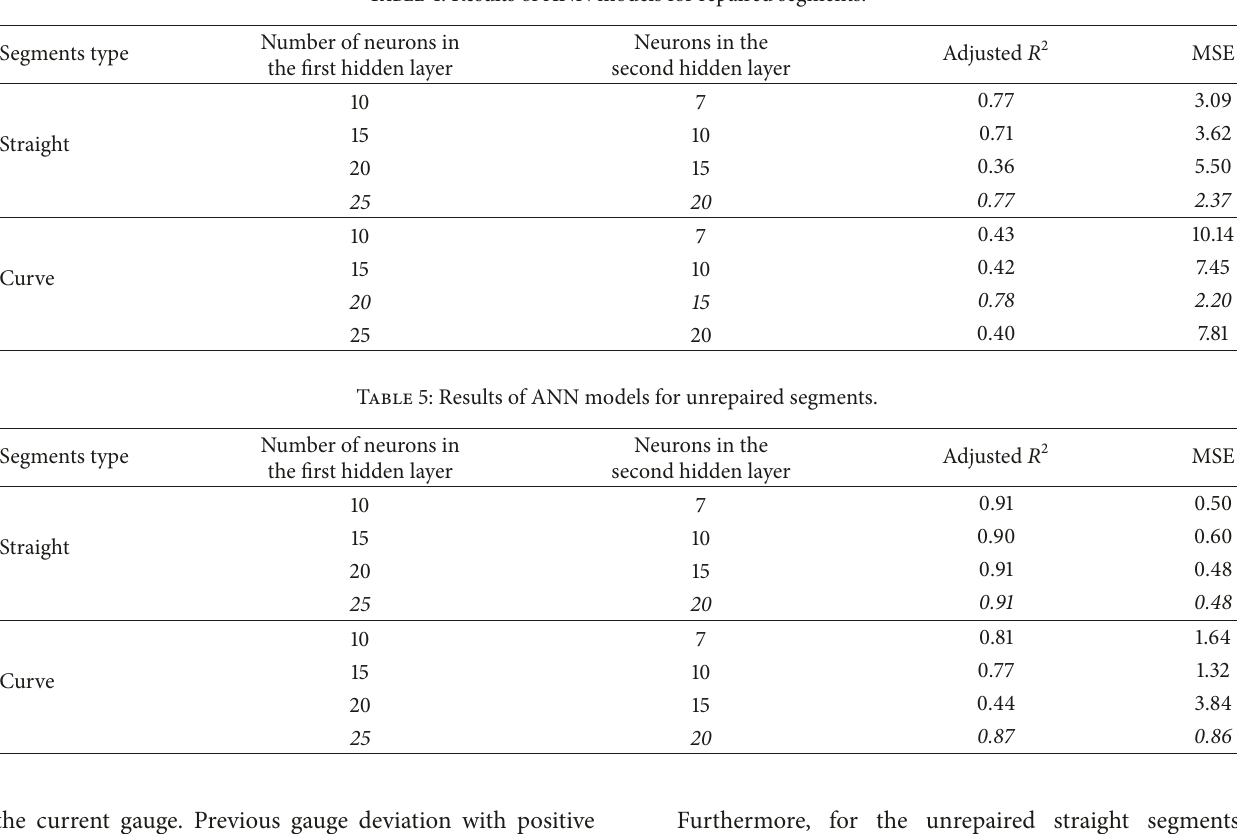
Table 4: Results of ANN models for repaired segments.